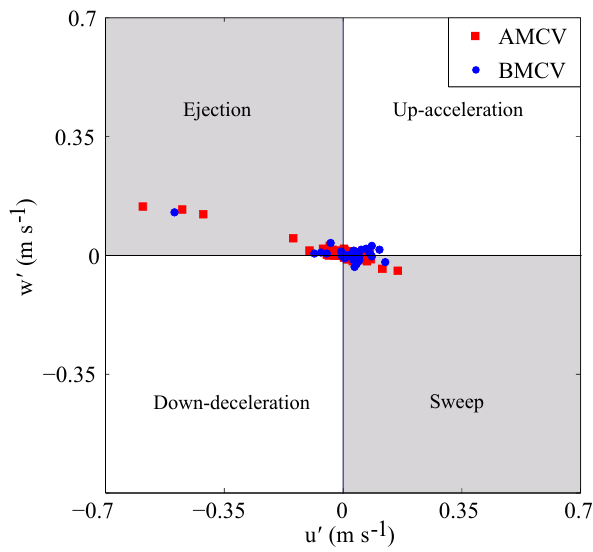
Figure 6. Classification of bursting events in u (cid:48) – w (cid:48) space identify- ing ejection, sweep, up-acceleration, and down-deceleration events both for above and below the measured mean critical velocity con-